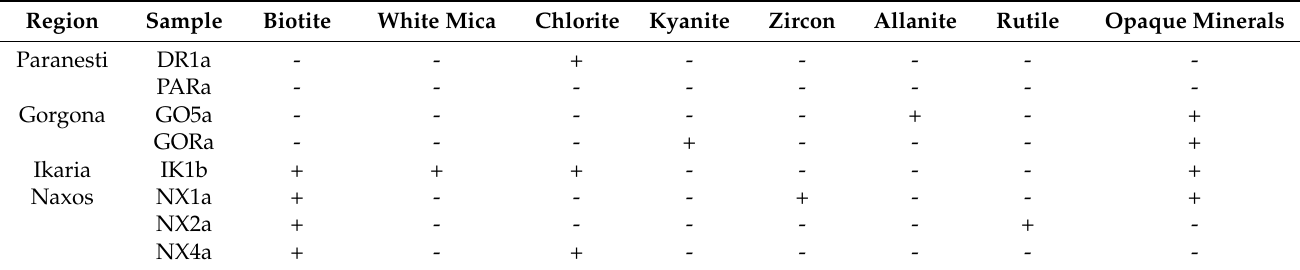
Table 3. Mineral inclusions of the Greek corundum studied under transmitted light microscope.